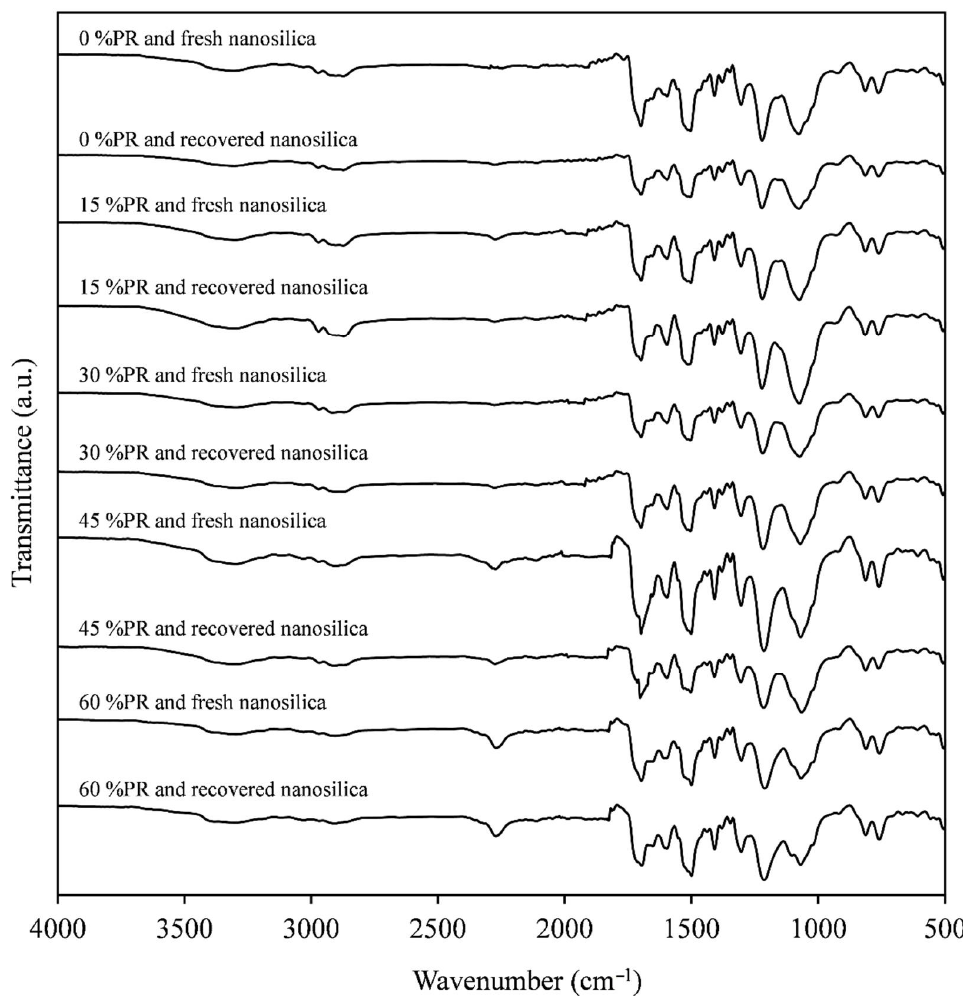
Figure 10. FTIR analysis of the synthesized foams using recovered polyol as a replacement of raw rigid polyol and fresh or recovered nanosilica. rigid polyol and fresh or recovered